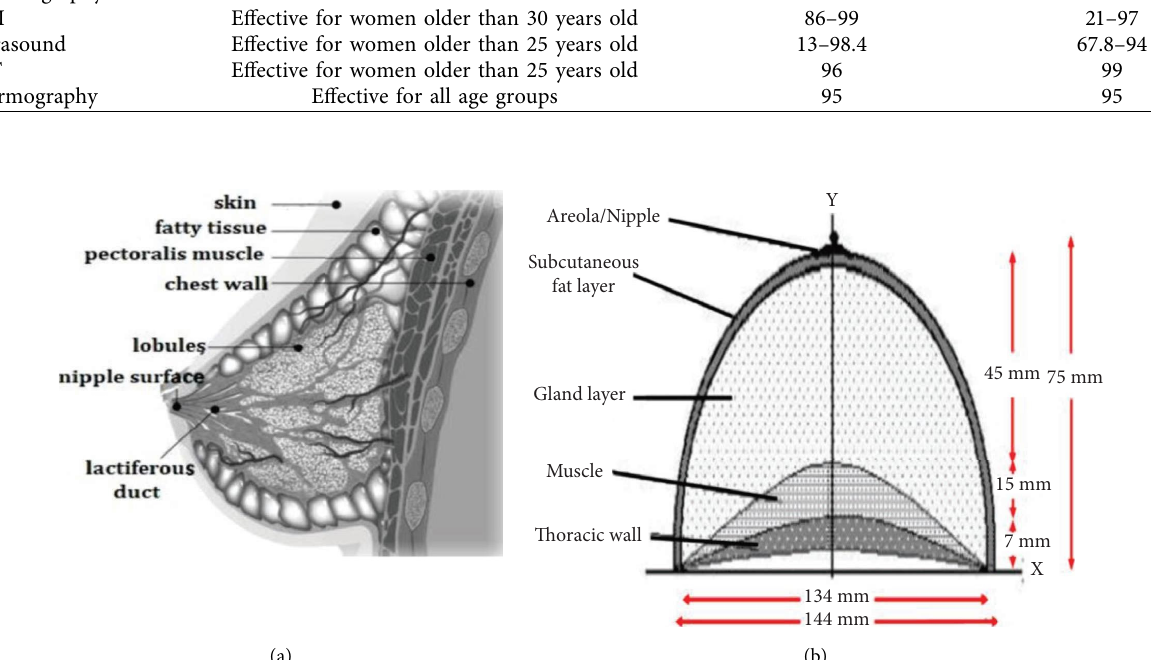
Figure 1: (a) Sagittal section of breast and anterior chest wall and (b) Cross-sectional view of physical domain composition of the